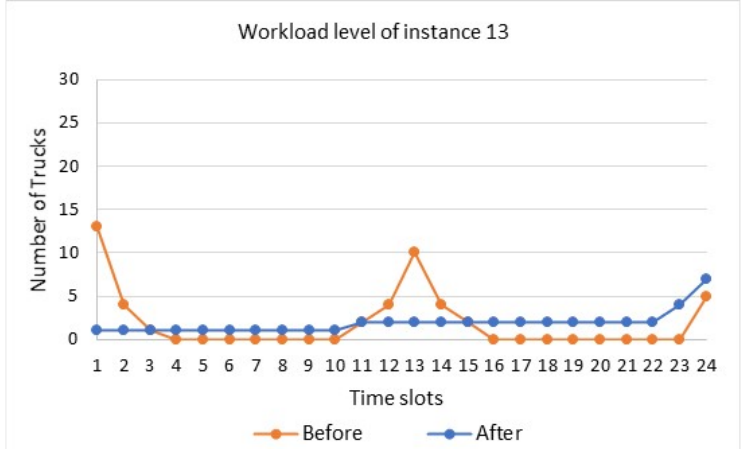
Figure 7. The effect of applying leveling constraint on instance 13.